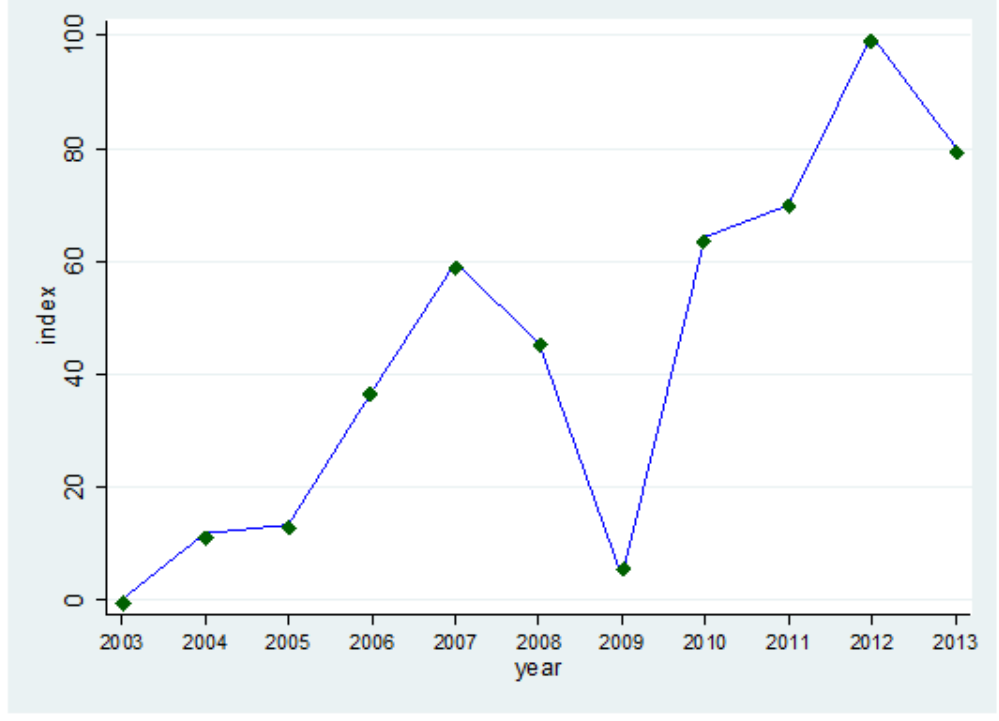
Figure 3. Financial Safety Index Change Trend